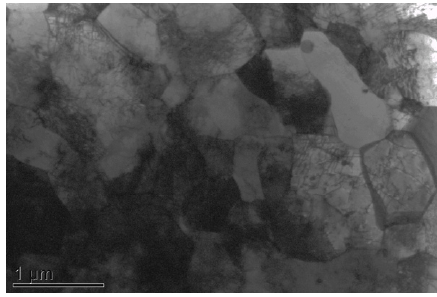
Figure 1. Transmission electron microscopy (TEM) image of the MA957 sample before ion ‐ irradiations. Materials 2016 , 9 , 15